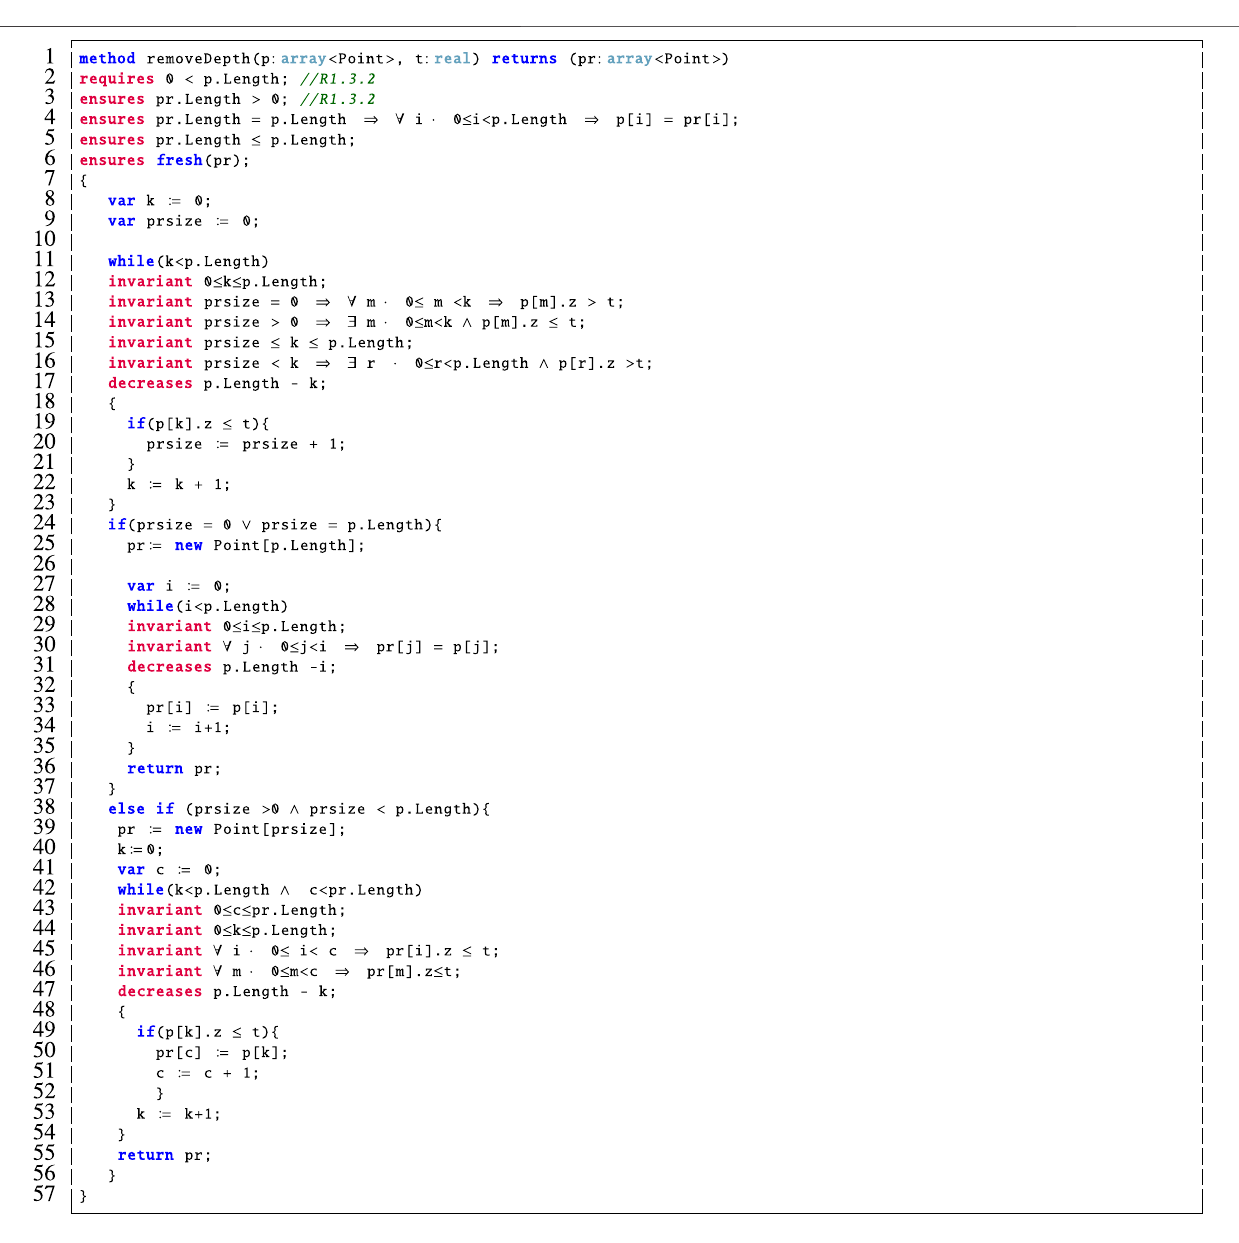
FIGURE 7 | Dafny encoding of the removeDepth method.